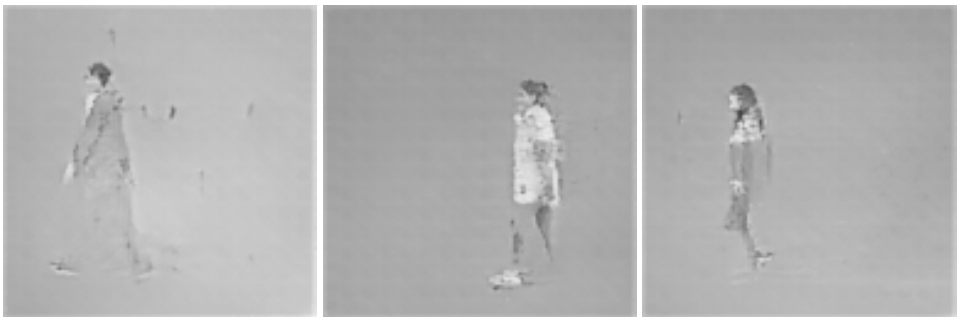
Figure 2. Reconstructed images from the DAVIS dataset [33] and DDD17 [34].